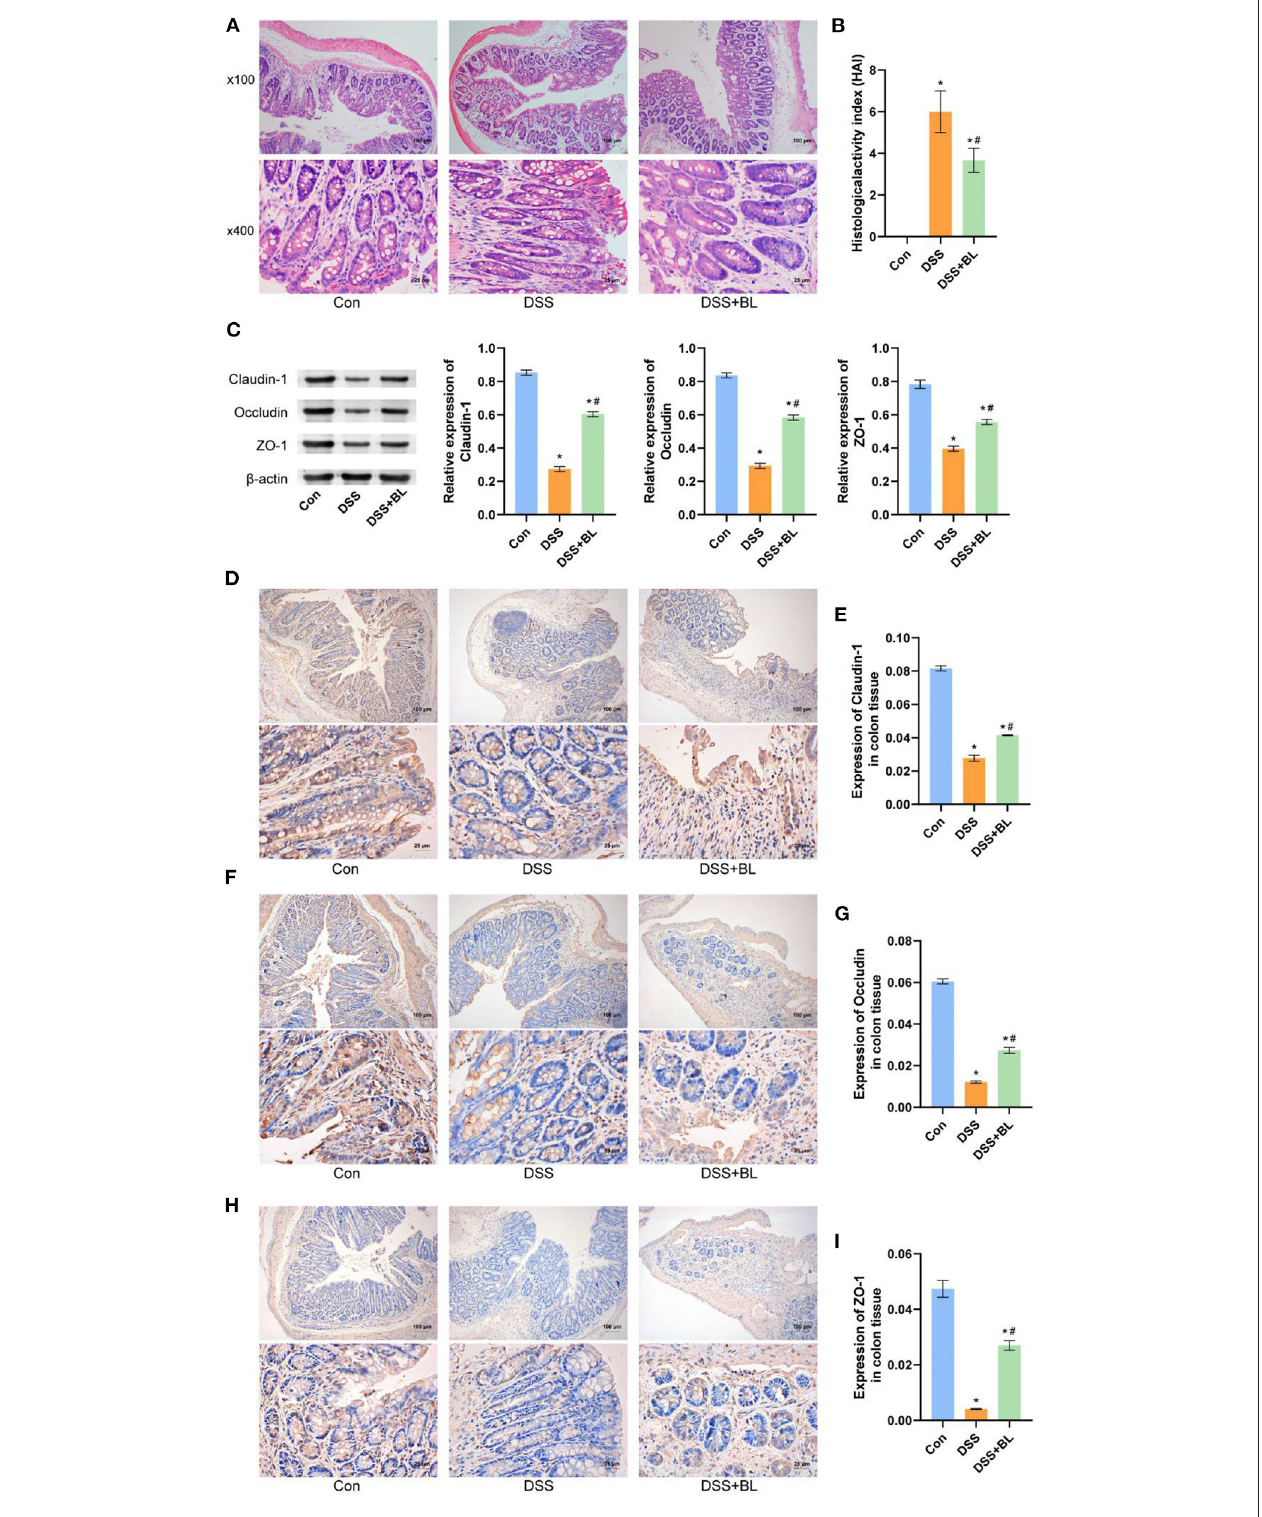
FIGURE 2 | Effects of bovine lactoferrin (BL) on colon tissue morphology and expression of colonic barrier-related connexin proteins in dextran sulfate sodium salt (DSS) mice. (A) H&E staining of colon tissue in mice. (B) Changes of histological activity index of colon tissue in mice. (C) Western blot results and analysis of Claudin-1, Occludin, and ZO-1. (D,E) Immunohistochemistry results and analysis of Claudin-1. (F,G) Immunohistochemistry results and analysis of Occludin. (H,I) Immunohistochemistry results and analysis of ZO-1. One-way ANOVA was used to compare the three groups. * P < 0.05 vs. control; # P < 0.05 vs. DSS. n = 6.